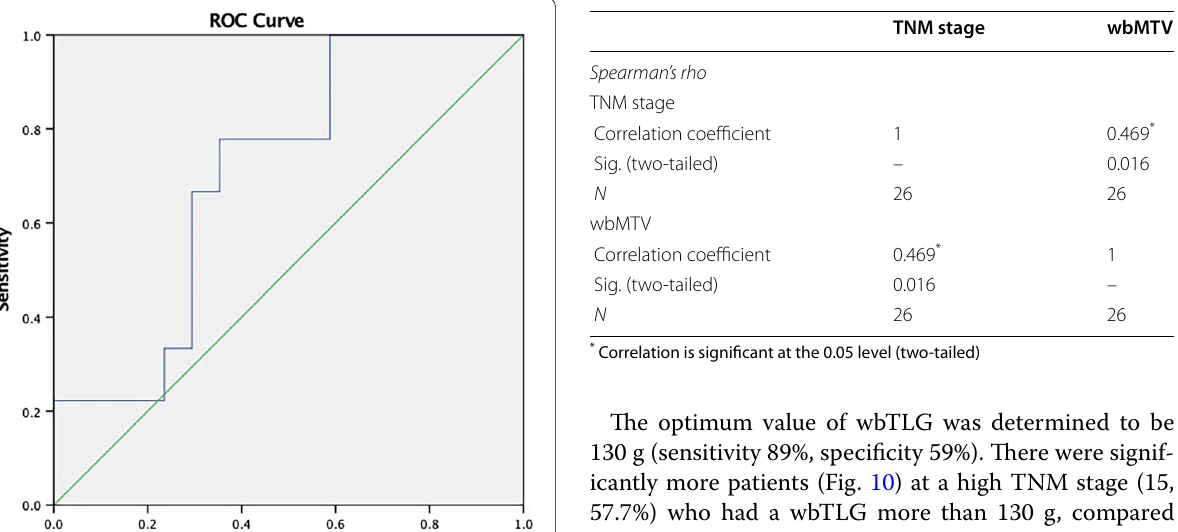
Table.4 Outcome according to mean SUVmax of 3.55 g/ml with TNM stage